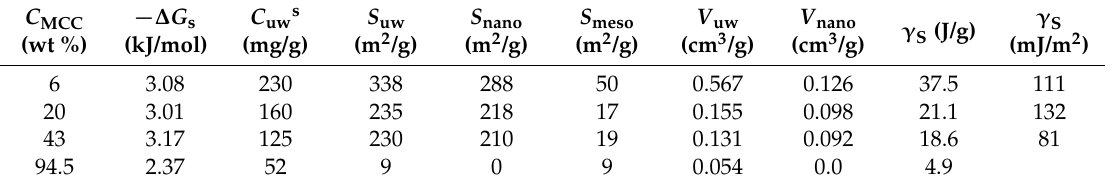
Table 4. Characteristics of water bound to MCC in aqueous suspensions and hydrated powders [13]. C MCC (wt %)